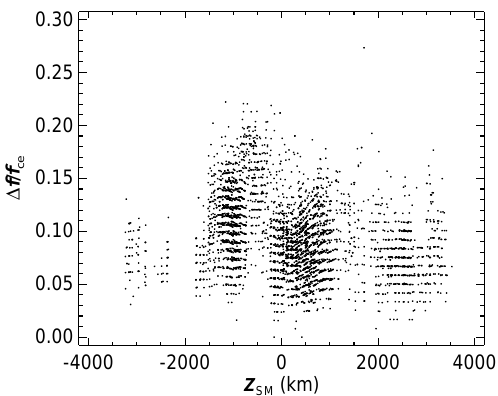
Fig. 3. An estimate of the probability density function of the dura- tion of chorus wave packets. The same data set as in Fig. 2 has been used.